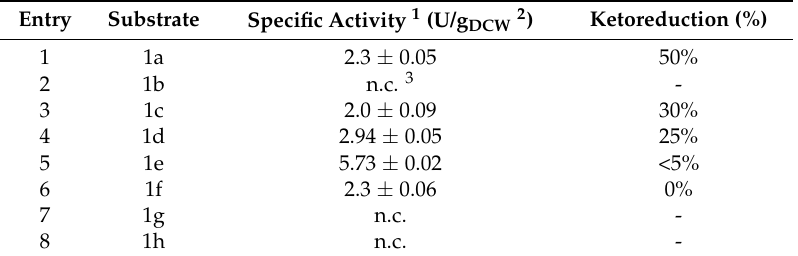
Table 2. Cyanobacterial Baeyer–Villiger Oxidation of cyclic ketones.